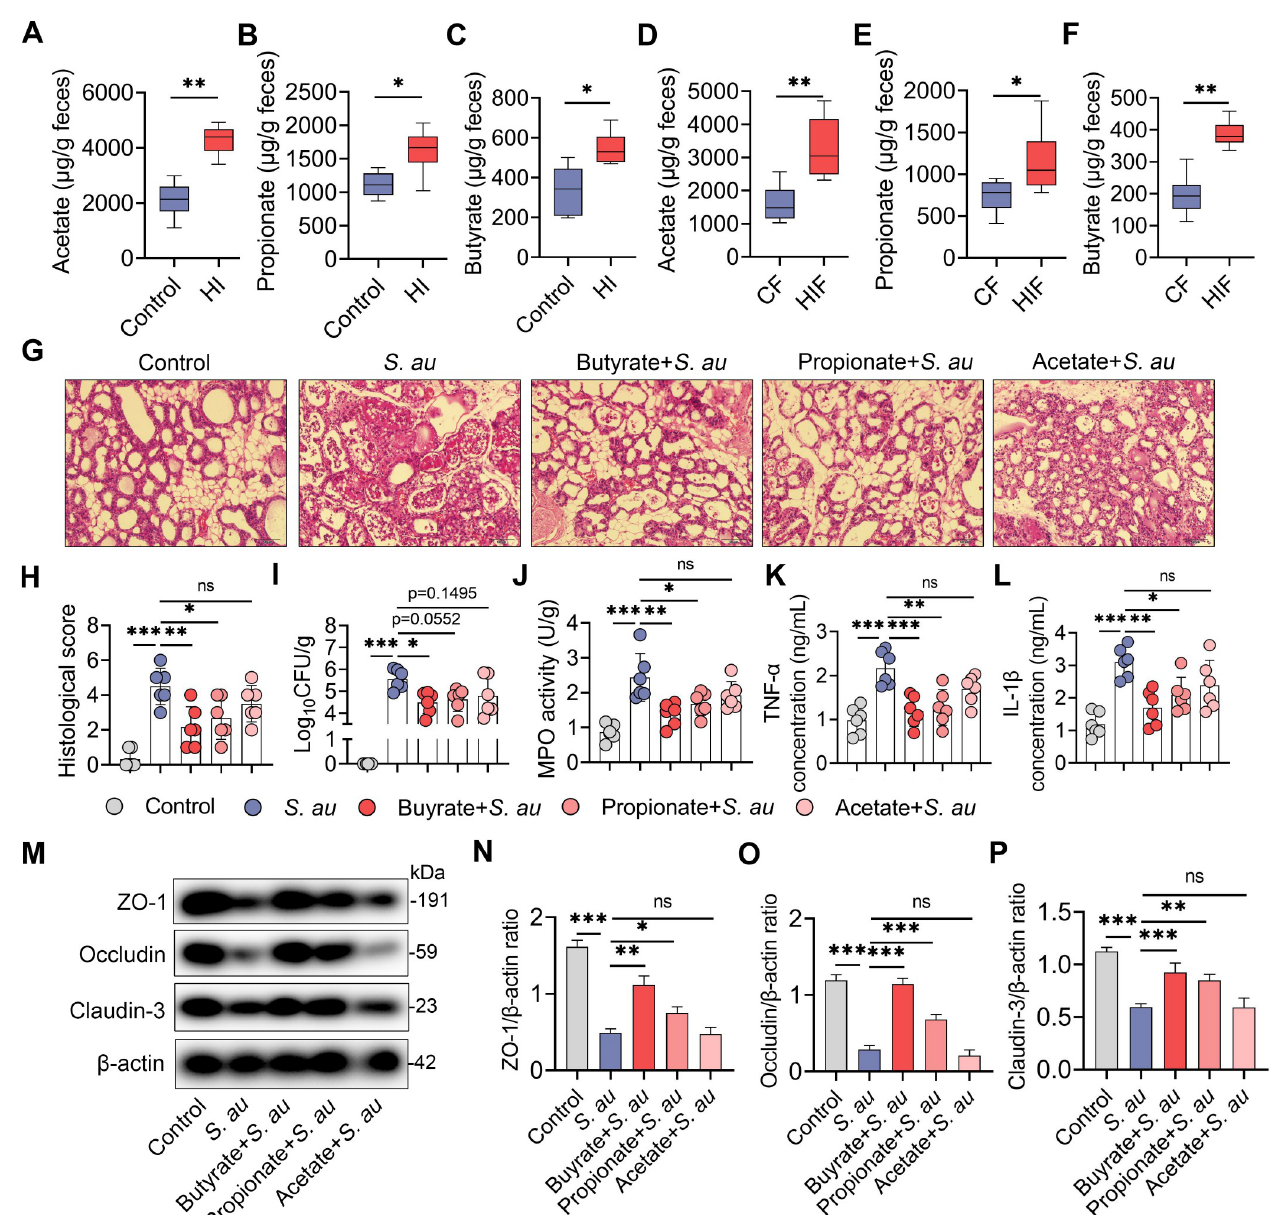
Fig 6. HI diet-derived SCFAs by gut microbiota metabolism alleviate S . au -induced mastitis in mice. A-C . Fecal acetate ( A ), propionate ( B ) and butyrate ( C ) levels from control diet- and HI diet-treated mice (n = 6). D-F . Fecal acetate ( D ), propionate ( E ) and butyrate ( F ) levels from different FMT groups (n = 6). G-P . Mice were treated with 30 mg/kg butyrate, propionate and acetate for a week, followed by S . au -induced mastitis (n = 6). G . Representative H&E-stained images of the mammary glands from different treatment groups (scale bar, 50 μ m). H . Histological score of the mammary gland based on H&E- stained sections (n = 6). I . Mammary S . au burden from the indicated groups (n = 6). J-L . Inflammatory markers, including MPO activity ( J ), TNF- α ( K ) and IL- β ( L ), from the indicated groups (n = 6). M . Representative images of mammary TJ proteins, including ZO-1, Occludin and Claudin-3, by western blotting. N-P . Relative intensity of TJ proteins including ZO-1 ( N ), Occludin ( O) and Claudin-3 ( P ), using β -actin as an endogenous control. Data are presented as boxplots ( A-F ) or means ± SD ( H-L and N-P ). The Mann-Whitney U test ( A-F ) and one-way ANOVA ( H-L and N-P ) were performed for statistical analysis. � p < 0.05, �� p < 0.01 and ��� p < 0.001 indicate significant